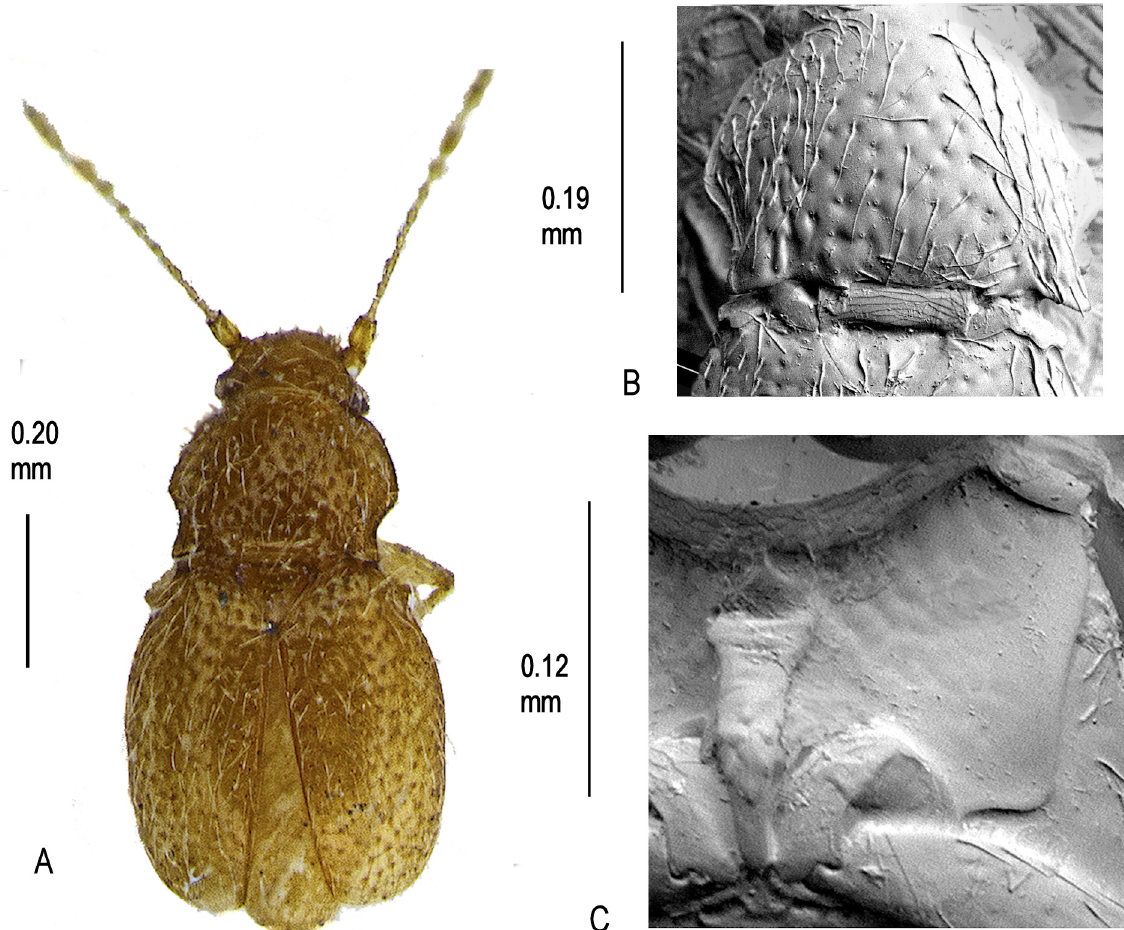
Fig. 53. Cissidium longum Darby, 2019. A . Habitus. B . Pronotum, × 485. C . Mesoventrite showing median process of collar, mid-keel and keel, ×